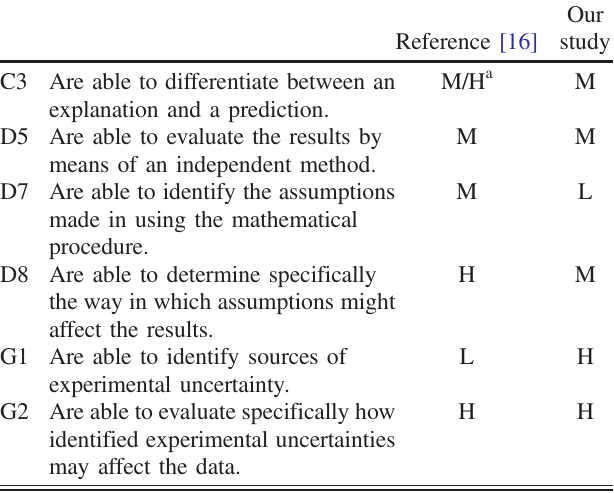
TABLE XIV. A tentative comparison between the difficulty levels of some subabilities as reported by Etkina, Karelina, and Ruibal-Villasenor [16] and as determined in our study. We used three difficulty levels as explained in the